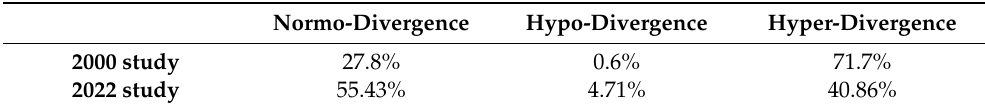
Table 16. Comparison of the distribution of divergence in patients enrolled in the epidemiological studies of 2000 and